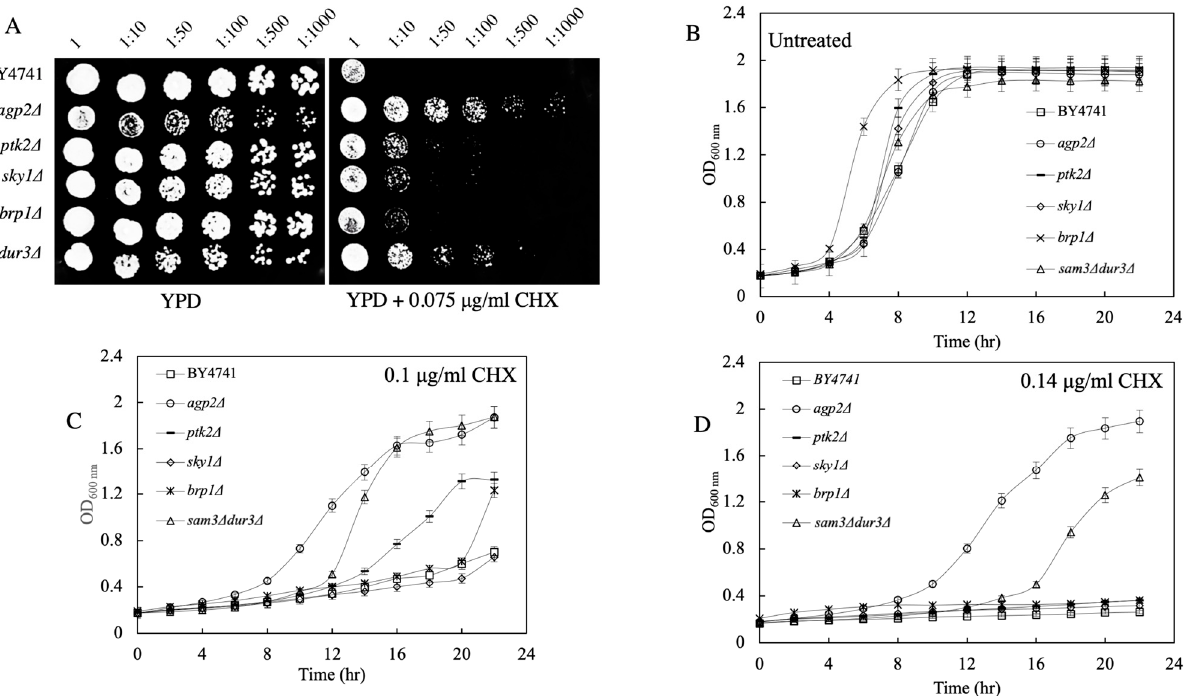
Figure 4. Survival analysis of the indicated strains showing that the agp2 ∆ mutant is resistant to the toxic effects of CHX. ( A ) Spot test analysis. Briefly, overnight cultures were serially diluted and spotted onto solid YPD plates without and with CHX. Plates were photographed after 72 h of incubation at 30 ◦ C. ( B – D ) Overnight cultures were adjusted to OD 600nm of ~0.2 in fresh YPD liquid media without and with CHX and the growth of the cells was monitored automatically using a plate reader equipped with an orbital shaker. Panel B shows growth of the cells untreated. Panel C and